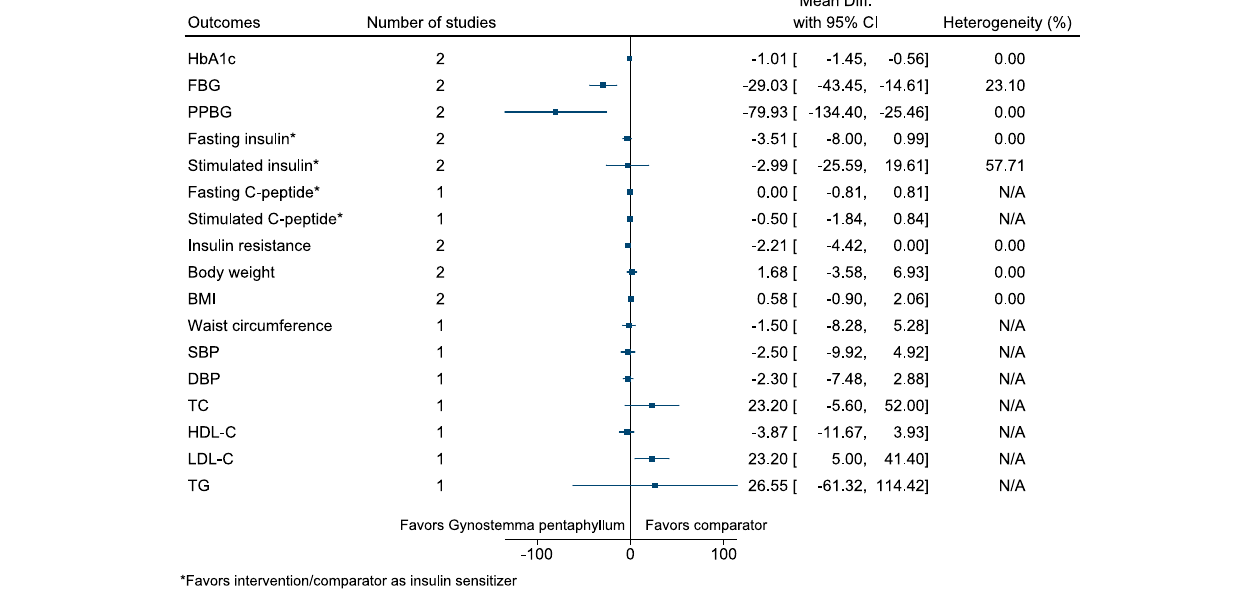
FIGURE 19 | Gynostemma pentaphyllum — Summary forest plot.